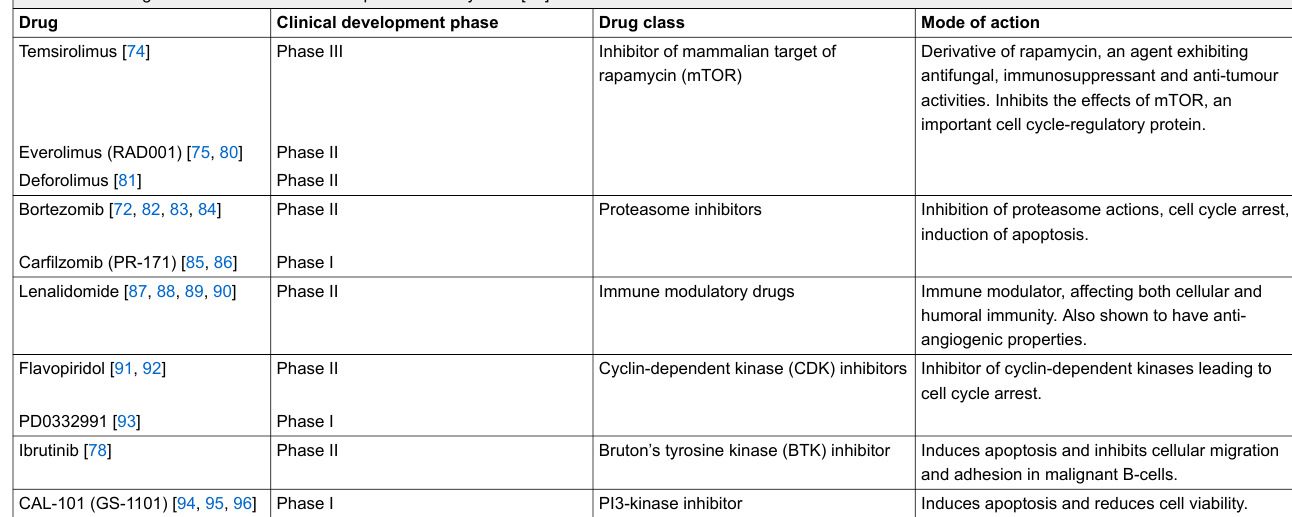
Table 3. Novel agents for the treatment of relapsed/refractory MCL [79]. Drug Clinical development